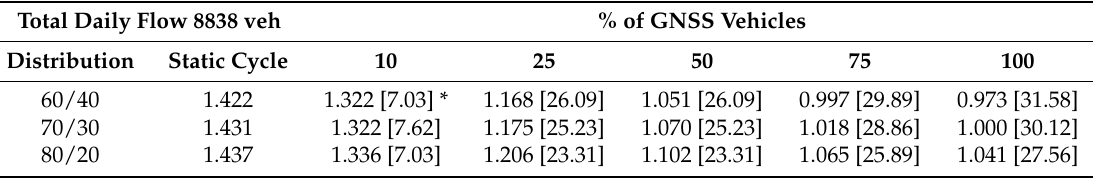
Table 10. Average NO x pollution [g/km], in a typical day, for Case B.